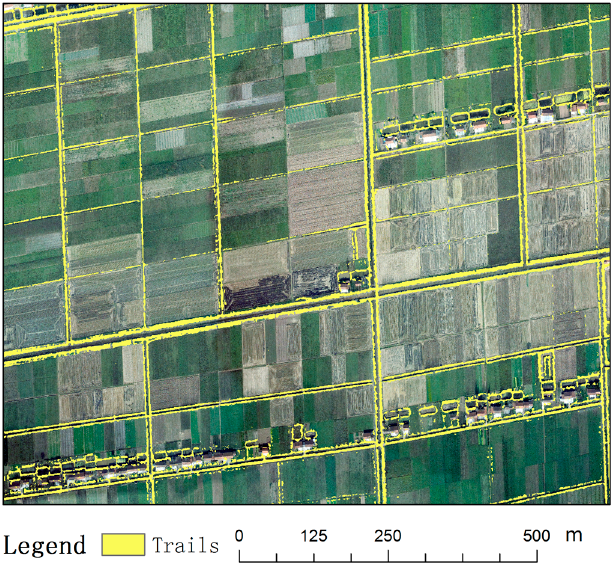
Figure 13. Trail polygons overlaid with an image.